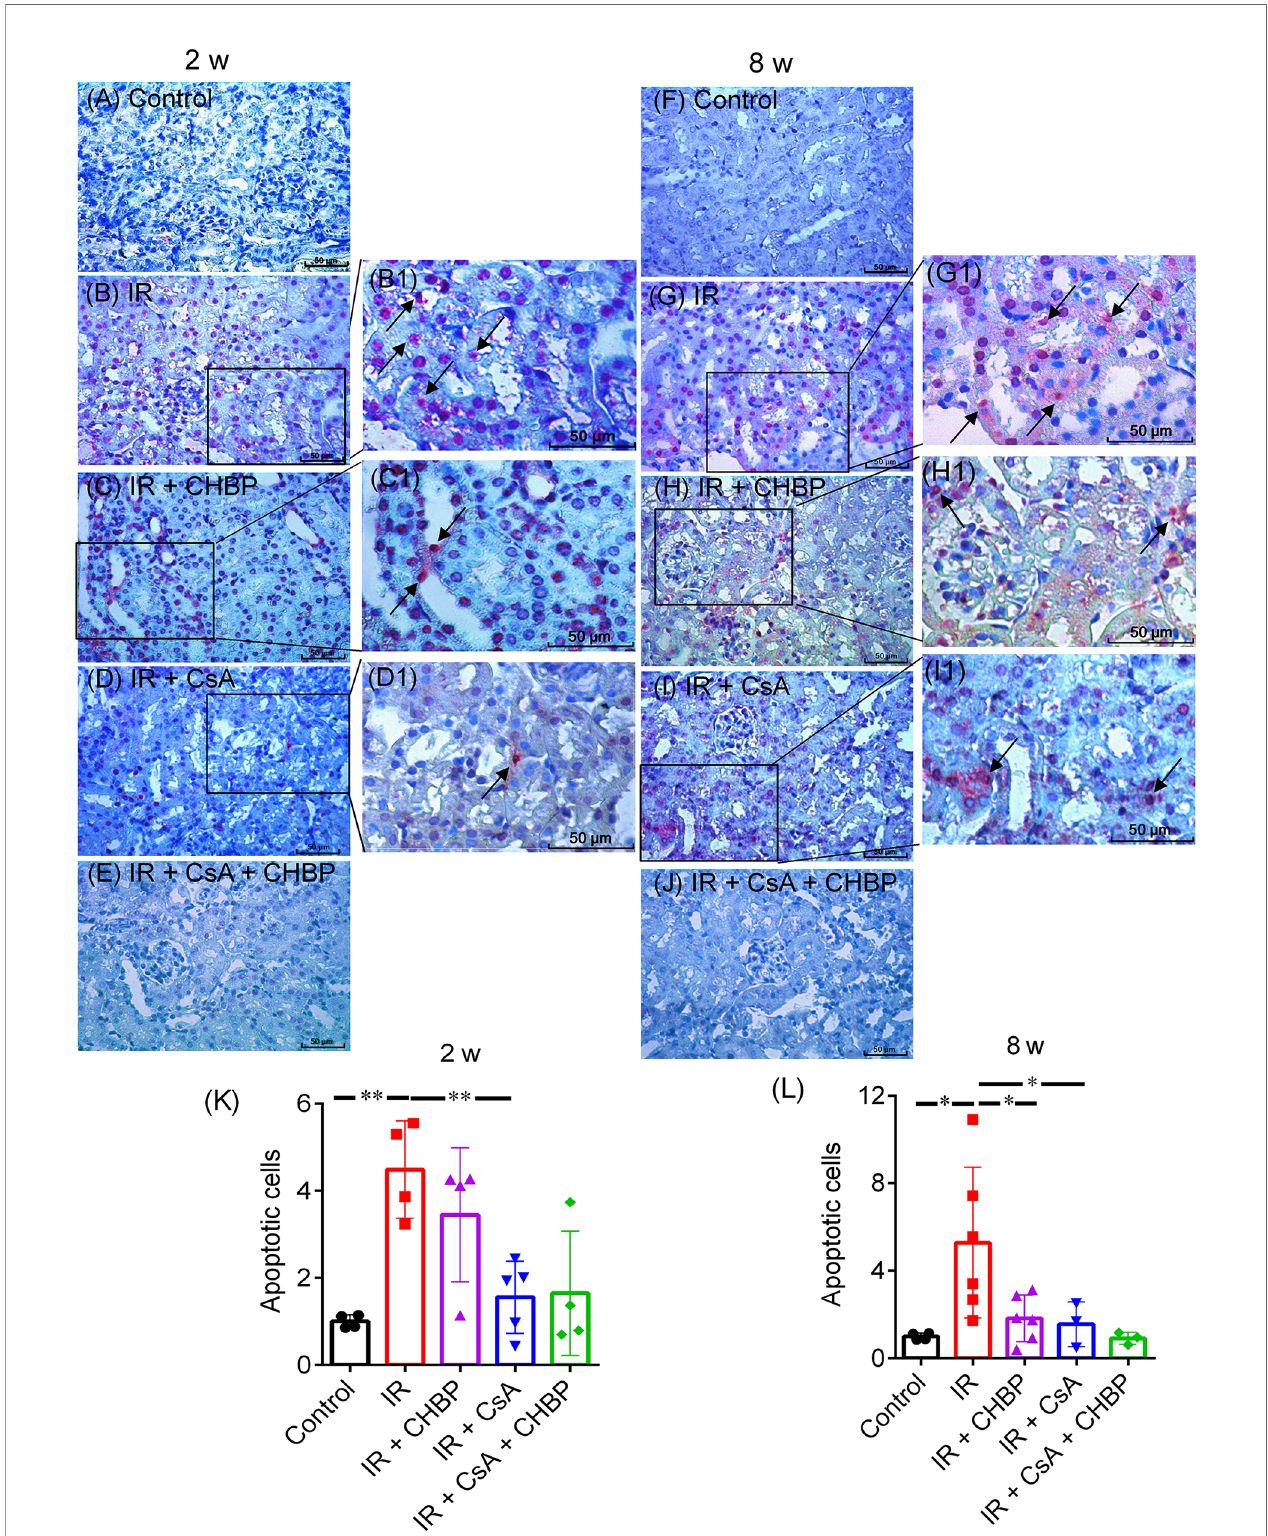
FIGURE 4 | Apoptotic cells detected by labelling fragmented DNAs. (A – J) Apoptosis were mainly shown in tubular and interstitial areas. (B1 – D1, G1 – I1) Enlarged pictures were from (B – D) and (G – I) . (K, L) The number of apoptotic cells was greatly increased by IR, but decreased by CsA at 2 and 8 weeks. CHBP treatment decreased apoptotic cells in the IR kidneys at 8 weeks. Data were expressed as the mean ± SD of each group (n ≥ 3). * P ≤ 0.05; ** P ≤